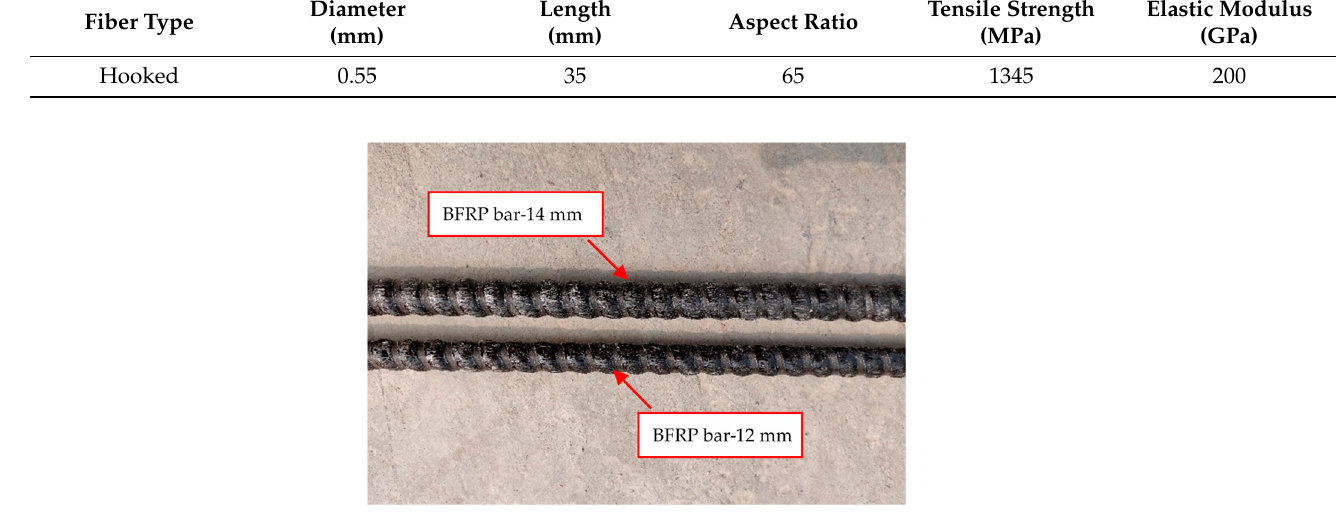
Figure 2. BFRP bars. Table 3. Mechanical properties of reinforcing bars.